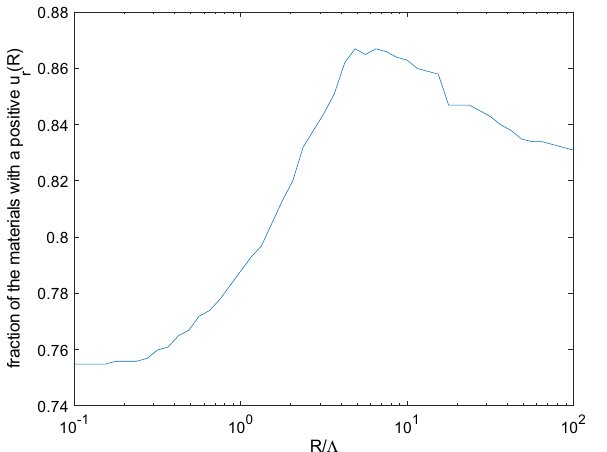
Figure 4. Fraction of the materials with a positive u r ( R ) as a function of the normalized sphere’s radius R /�